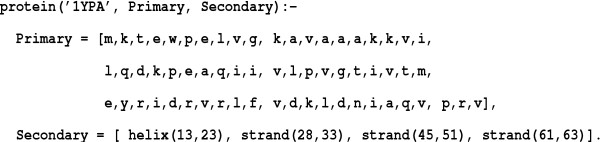
Protein sequence and secondary structure representation